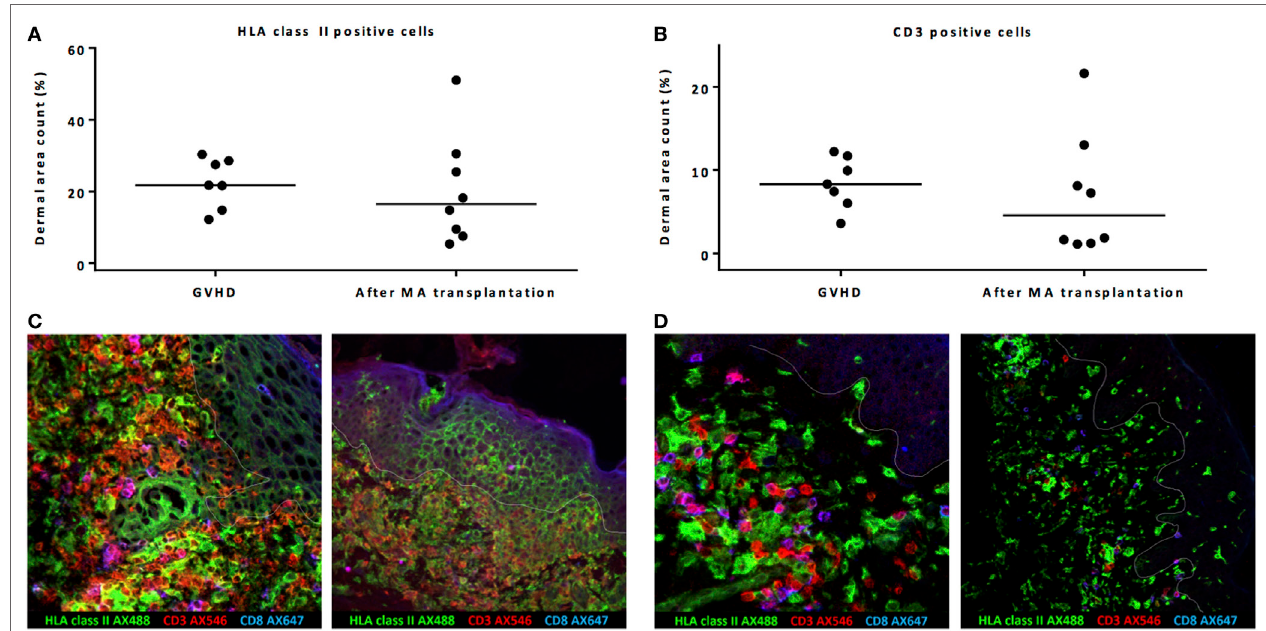
FigUre 3 | Biopsies from patients with acute skin graft-versus-host disease (GVHD) showed massive inflammation. Both dermal area count (excluding by definition the epidermal area count) of HLA class II-positive cells (a) and CD3-positive cells (B) were not significantly different between biopsies taken during acute skin GVHD and biopsies of normal skin taken 24 weeks after myeloablative (MA) allogeneic stem cell transplantation (alloSCT). However, immunofluorescence microscopy showed honeycomb pattern of HLA class II expression on epidermal cells and upregulation of HLA class II expression on T-cells (yellow hued cells) during GVHD as signs of inflammation (c) , while in normal skin biopsies 24 weeks after MA alloSCT, co-localization of HLA class II-positive cells and T-cells without interaction was observed (D) . Pink hued cells represent CD8-positive CD3 T-cells. White line demarks the border between dermis and